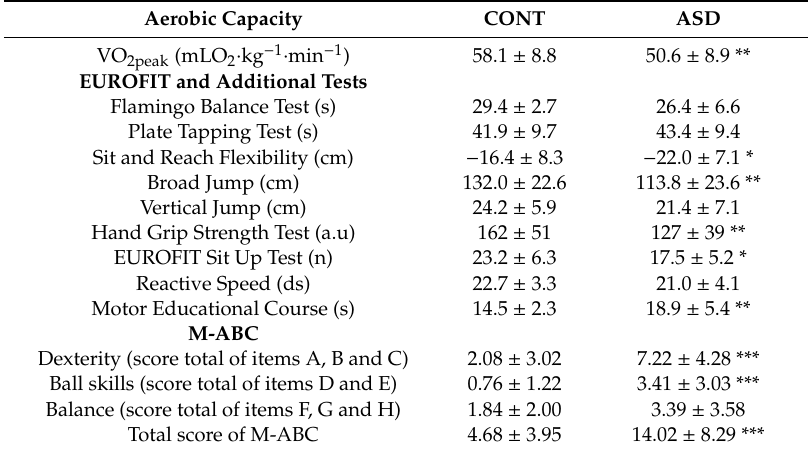
Table 2. Motor assessment by European Physical Fitness Test Battery (EUROFIT) and the Movement Assessment Battery for Children